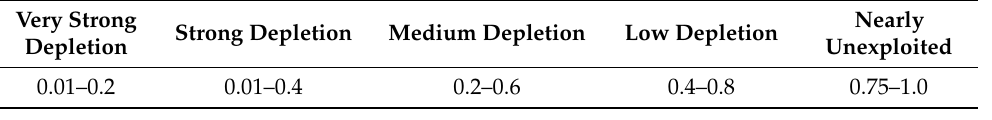
Table 3. Prior relative biomass ranges (B/K) for CMSY+.